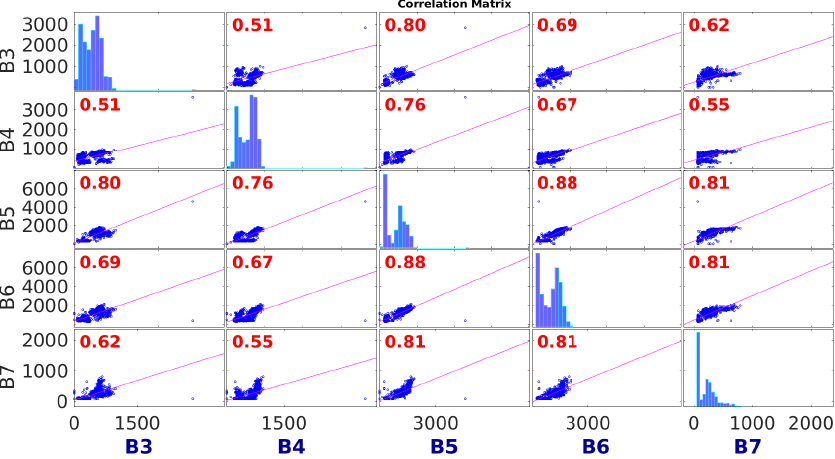
Figure 7. Energy consumption correlation between days for Buildings B 3 – B 7